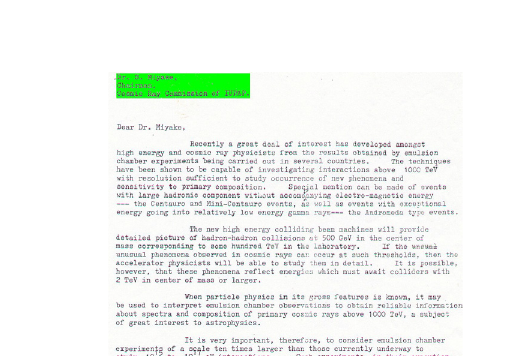
Table 1. Comparison of similar words